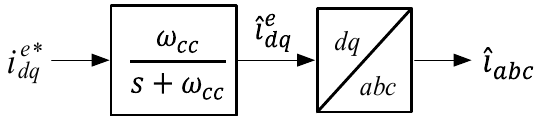
Figure 14. Block diagram of acquiring estimated current.